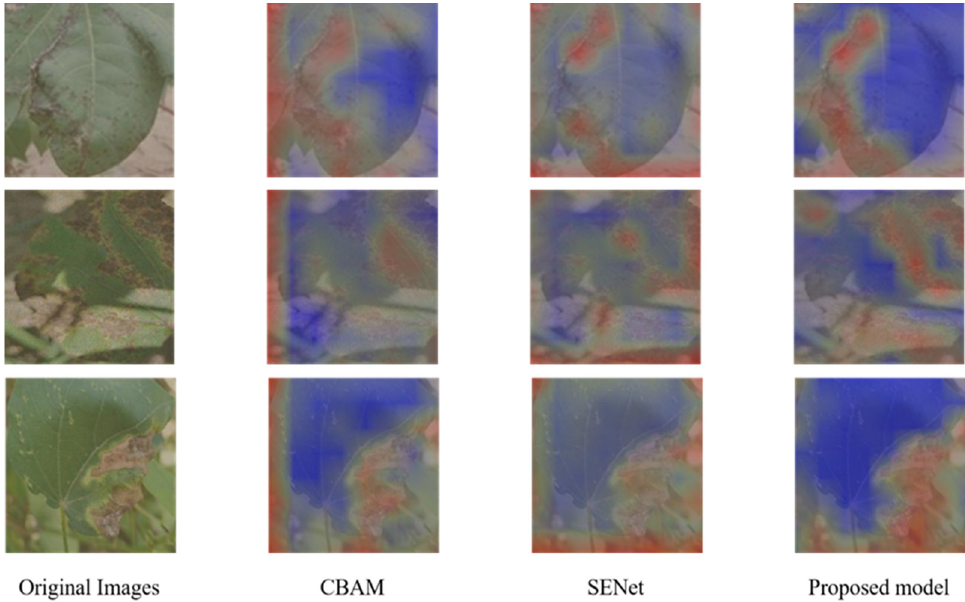
Figure 8. Visual results of cotton leaf disease identification based on SENet, CBAM, and the pro- posed model.